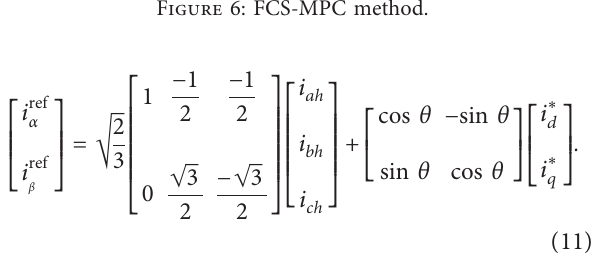
Figure 6: FCS-MPC method.